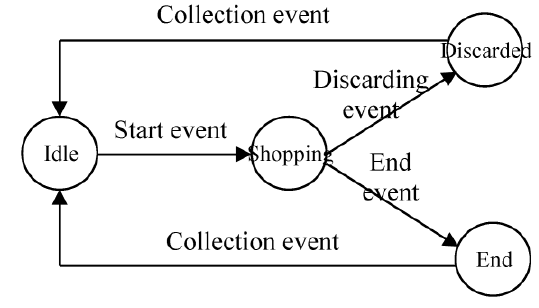
Figure 4. The finite state machine model for shopping